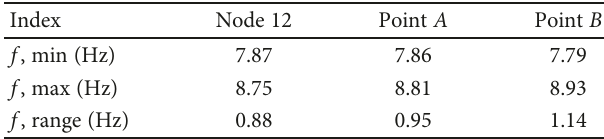
Table 8: D2, excitation far from the damage, localization indexes.